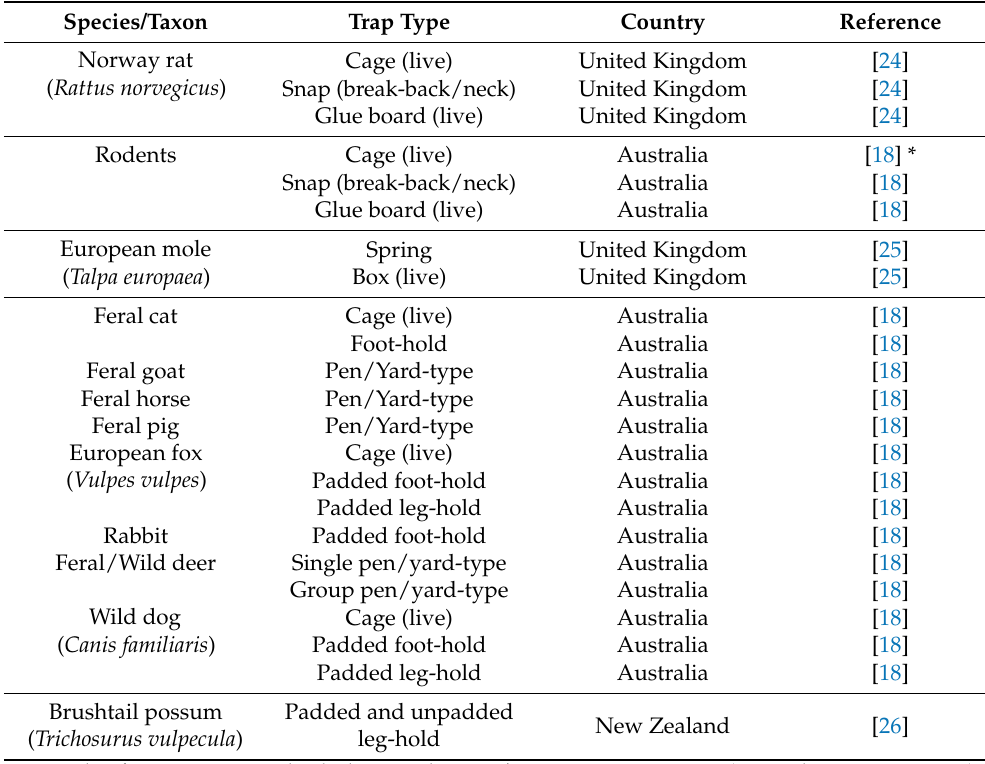
Table 1. Application of the Sharp and Saunders humaneness assessment model to evaluate the welfare impacts of various types of traps on different species of